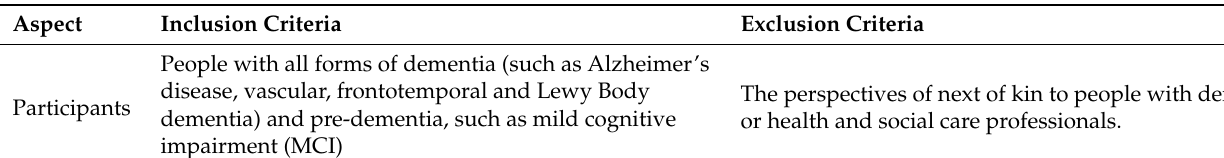
Table 1. Inclusion and exclusion criteria.